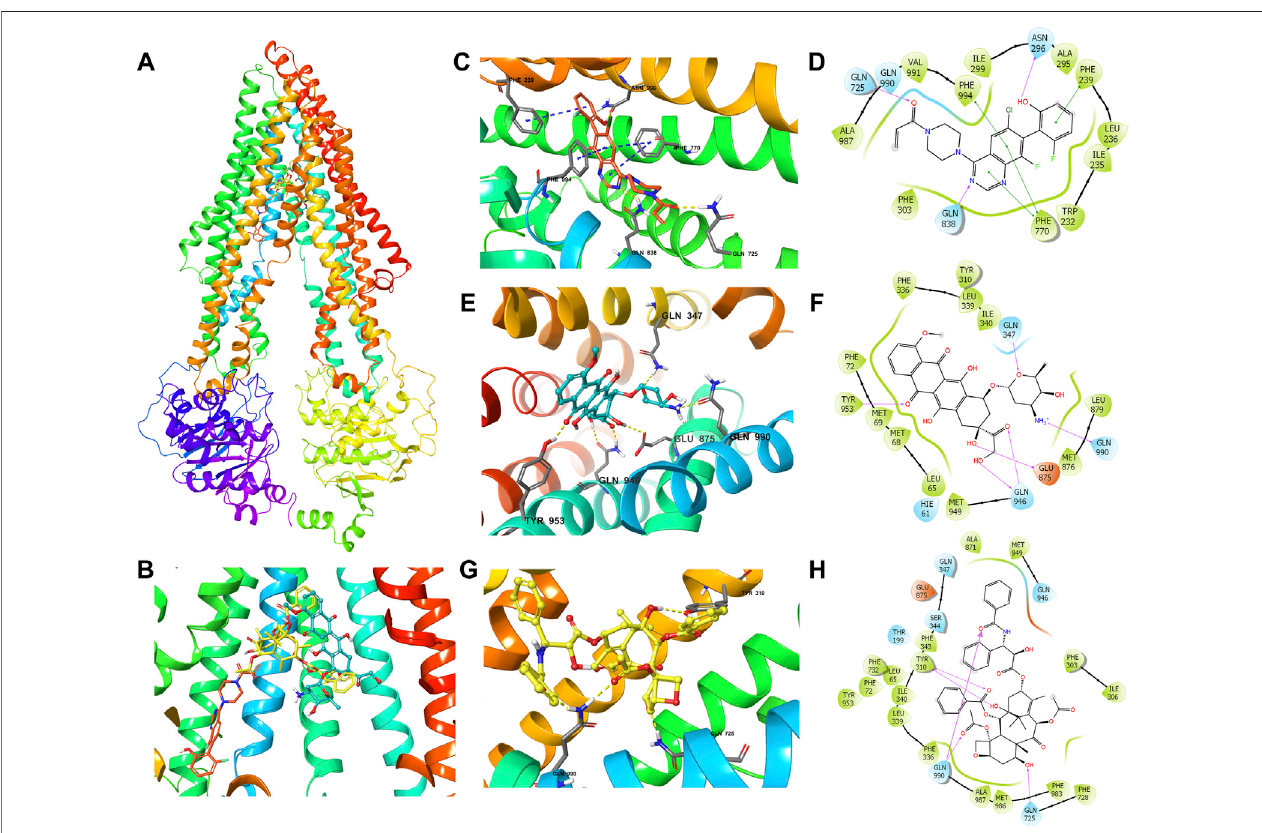
FIGURE6| ThemolecularmodelingofARS-1620, doxorubicin, and paclitaxel withhuman ABCB1. (A) Thebinding site ofARS-1620 (orange), doxorubicin (cyan), and paclitaxel (yellow) within human ABCB1. (B) The enlarged diagram of ARS-1620, paclitaxel, and doxorubicin within the binding site of human ABCB1. The interactions of ARS-1620 (C) , doxorubicin (E) , and paclitaxel (G) with the ABCB1 model in the three-dimension diagram. Ligands are shown as ball and stick mode: nitrogen — blue, oxygen — red, hydrogen — white, chloride — green, fl uoride — light cyan. Interactions are indicated: hydrogen bonds — yellow dotted short line, π - π stacking — blue dotted short line. The interactions of ARS-1620 (D) , doxorubicin (F) , and paclitaxel (H) with the ABCB1 model in the two-dimension diagram: purple arrow hydrogen bond, green short line — π - π interaction.